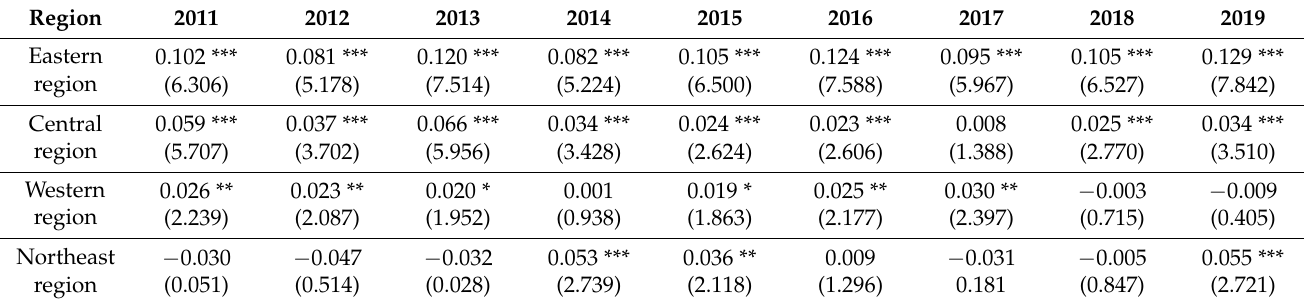
Table 6. Global spatial correlations of CD&GDD in four economic